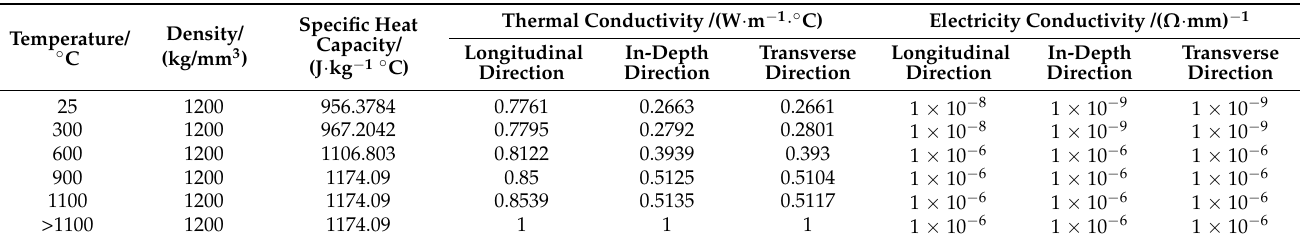
Table 1. Physical properties of GFRC materials.